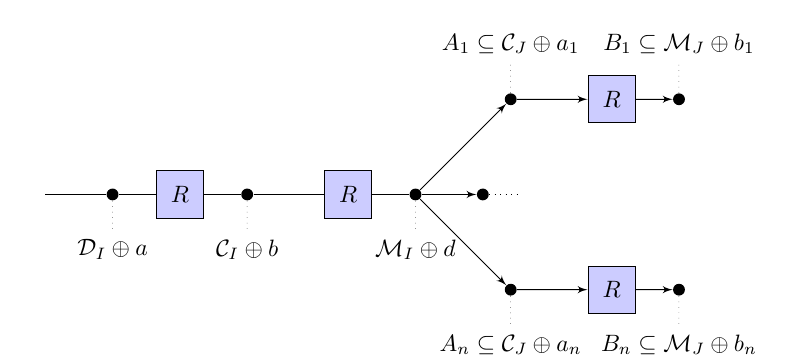
Figure 6: 3-round distinguishers for AES (the index n is defined as n := (2 8 ) 4 ·| I |−| I |·| J | ). belong to the same coset of M I . Since a coset of M I can be seen as the union of (2 8 ) 4 ·| I |−| I |·| J | cosets of C J , the probability that these two elements belong to the